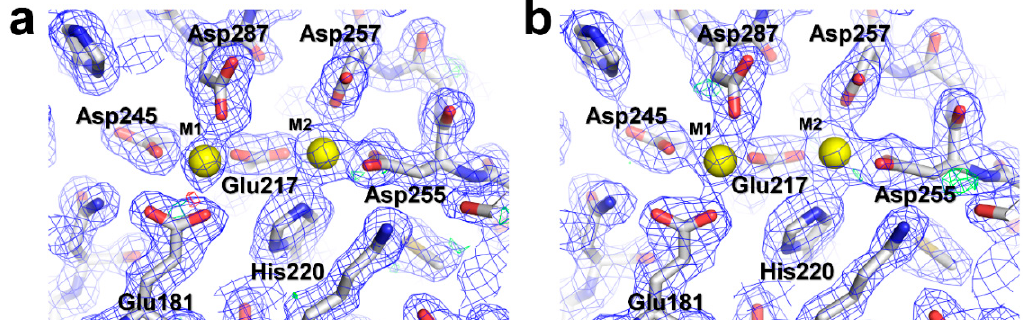
Figure 6. Both 2mFo-DFc (blue, 1.2 σ ) and mFo-DFc (green, 3.0 σ and red, − 3.0 σ ) electron density maps of metal binding sites in glucose isomerase by ( a ) 100 ms X-ray exposure with 0.011° oscillation, and ( b ) 500 ms X-ray exposure with 0.222° oscillation.